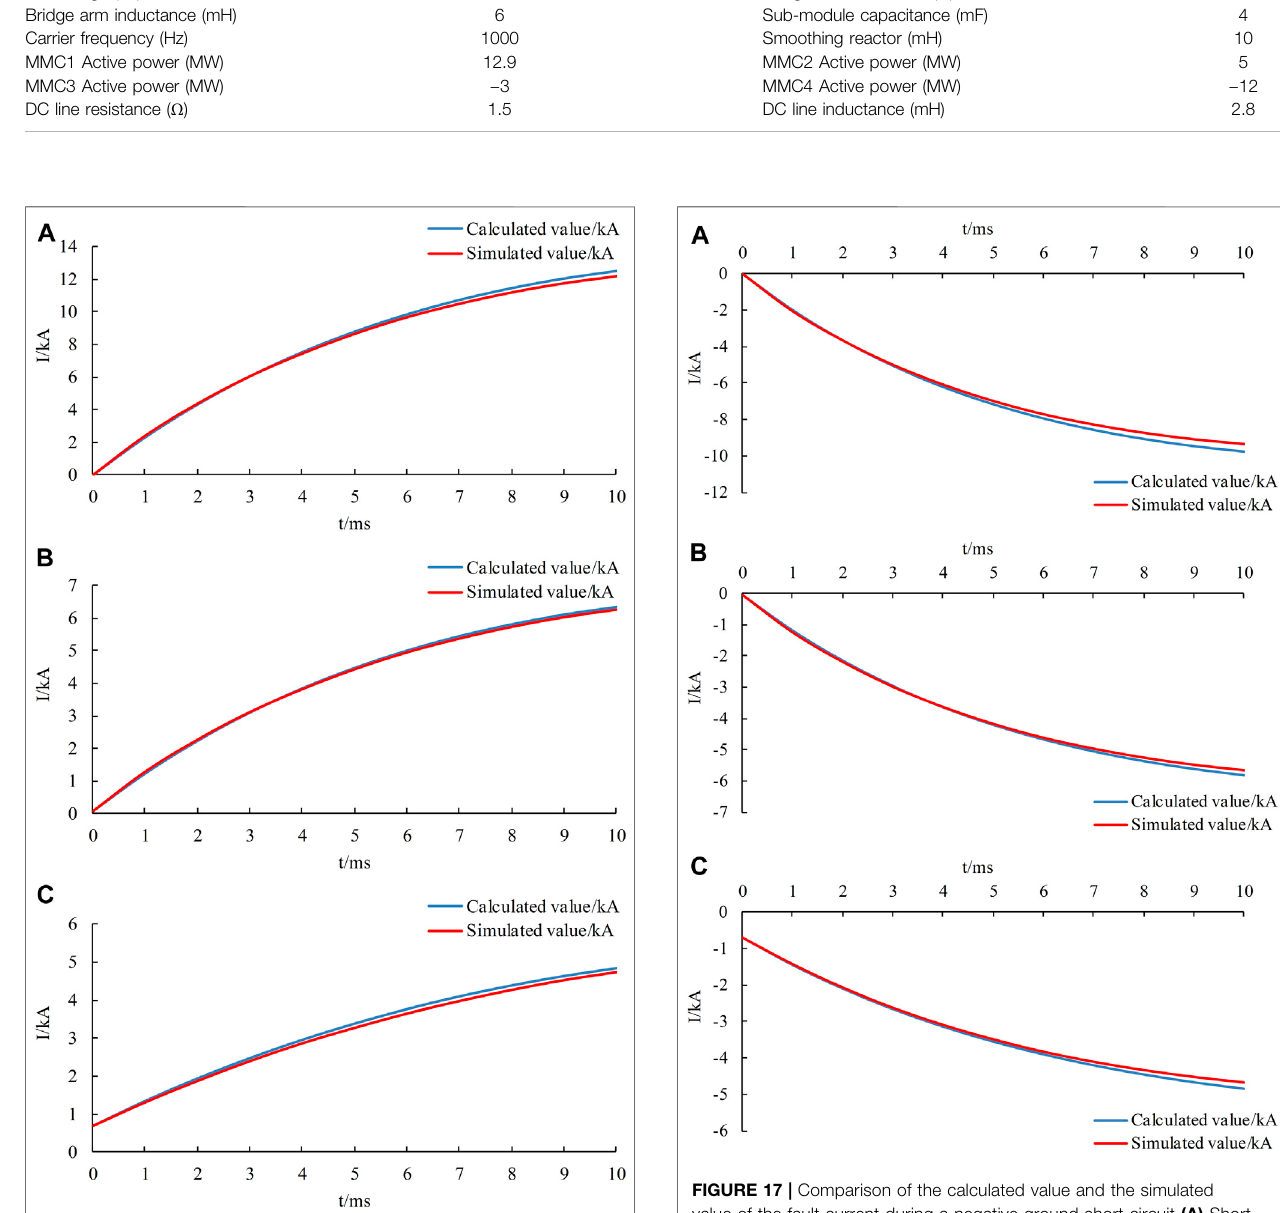
FIGURE 16 | Comparison of the calculated valueand the simulated value of thefaultcurrentduringainter-poleshortcircuit (A) Shortcircuitcurrentatfaultpoint. (B) Positive current fl owing from MMC1 to MMC2 on the fault line. (C) Positive current at the outlet of MMC1.